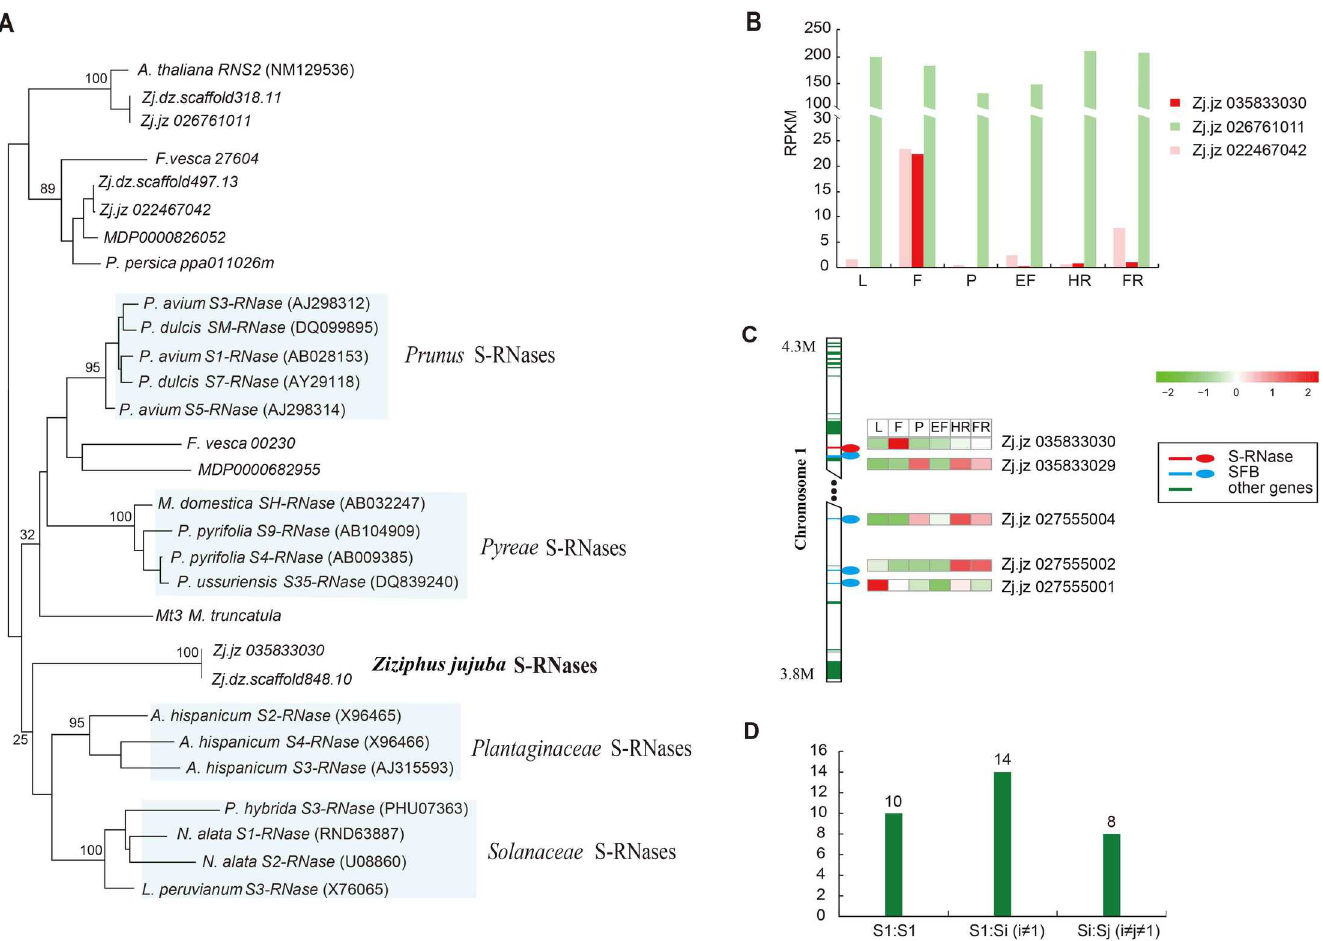
Fig 4. Characterization of the jujube S locus. (A) Phylogenetic analysisof three T2-RNase sequencesfrom each ‘Junzao’(Zj.jz) and ‘Dongzao’(Zj.dz) with other known S genes. ( B) Expression (RPKM) of S -RNaseand S -like RNase genes in different tissues. (C) Physical positionsof S -RNaseand SFB genes on chromosome 1 of the ‘Junzao’genome.The scaled log 2 expressionvalues (RPKM) are shown in the heat map. From left to right, leaf (L), flower (F), phloem(P), expandingfruit (EF), half-red fruit (HR) and full-red fruit (FR). ( D) Frequencyof S -locus genotypes in 32 jujubeaccessions.